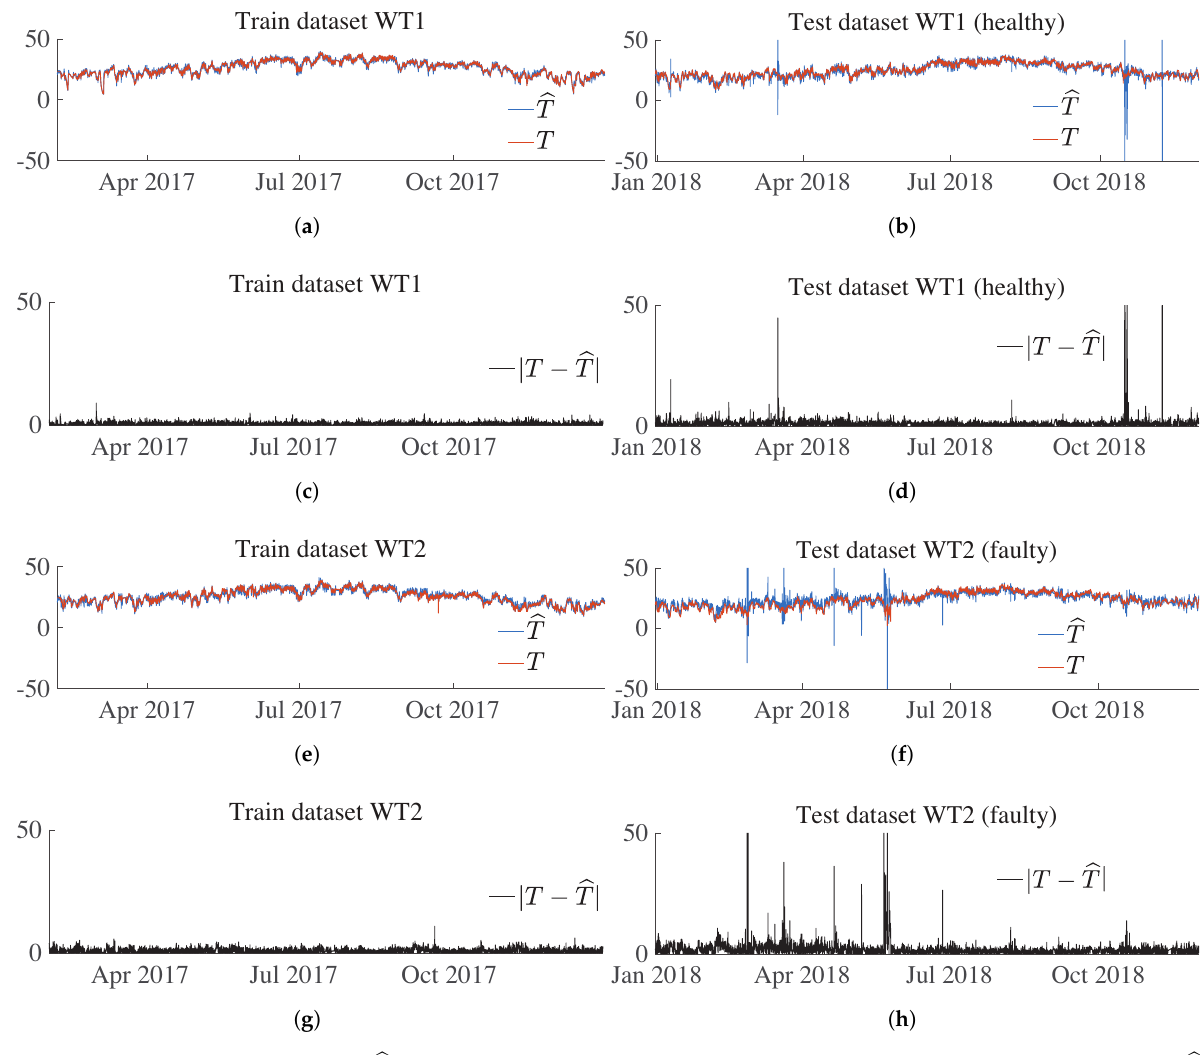
Figure 16. ( a ) ANN predicted value ( (cid:98) T ) and target ( T ) value for WT1 over the train dataset. ( b ) ANN predicted value ( (cid:98) T ) and target ( T ) value for WT1 over the test dataset. ( c ) Absolute difference value between the prediction and estimation, | T − (cid:98) T | , for WT1 over the train dataset. ( d ) Absolute difference value between the prediction and estimation, | T − (cid:98) T | , for WT1 over the test dataset. ( e ) ANN predicted value ( (cid:98) T ) and target ( T ) value for WT2 over the train dataset. ( f ) ANN predicted value ( (cid:98) T ) and target ( T ) value for WT2 over the test dataset. ( g ) Absolute difference value between the prediction and estimation, | T − (cid:98) T | , for WT2 over the train dataset. ( h ) Absolute difference value between the prediction and estimation, | T − (cid:98) T | , for WT2 over the test